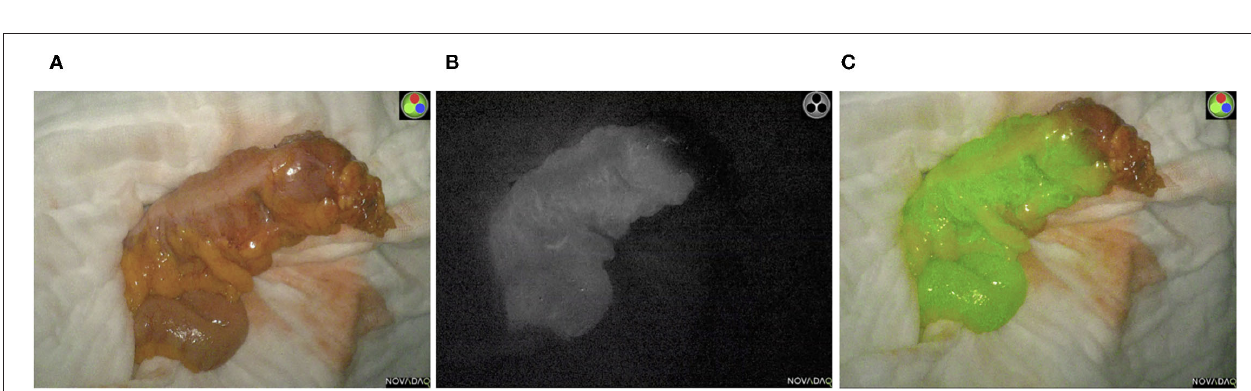
anastomotic perfusion, potentially reducing the AL rate (7,